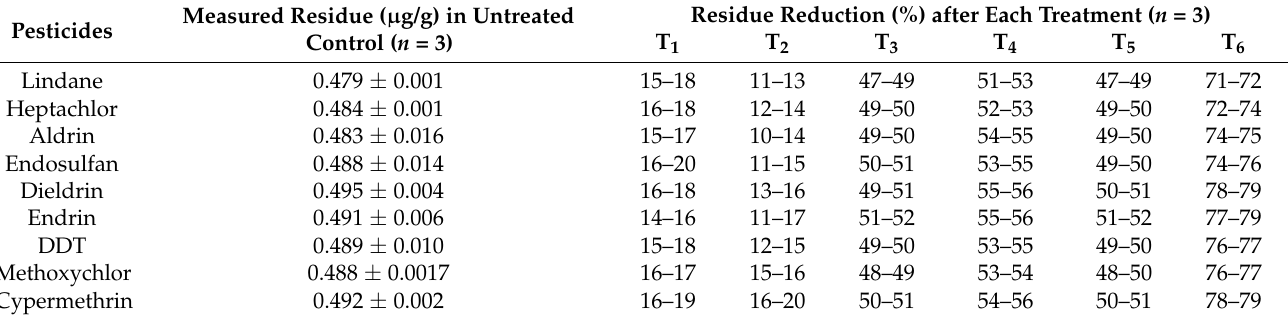
Table 3. Reduction in pesticide residues (%) in Clarias gariepinus by household